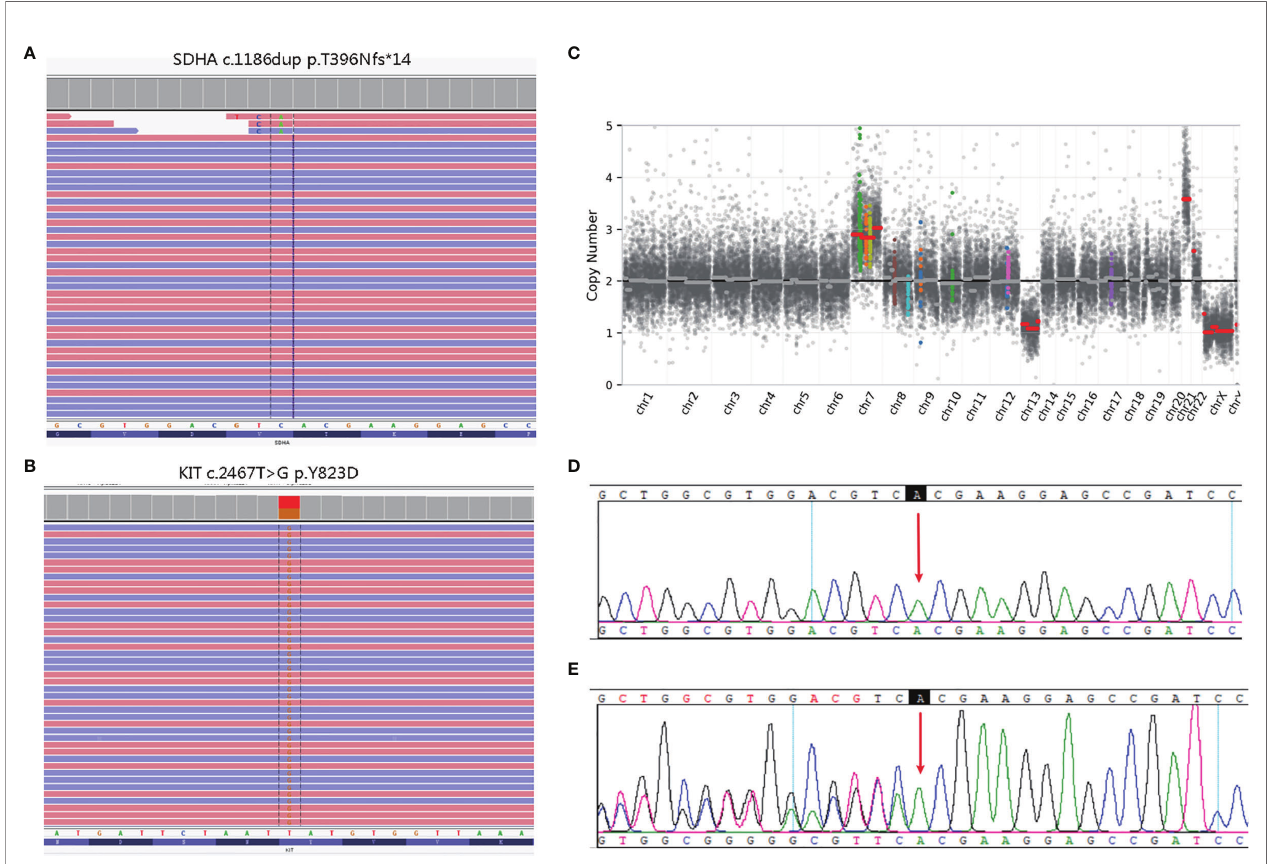
FIGURE 2 | Molecular pathology data of patient. Next generation sequencing (NGS) revealing a germline SDHA c.1186dup variant (A) , and a somatic KIT c.2467T>G variant (B) . Copy number variation (CNV) in the whole genome (C) . The unaffected father of the patient carried the heterozygous SDHA c.1186dup mutation (E) , whereas the healthy mother did not (D)